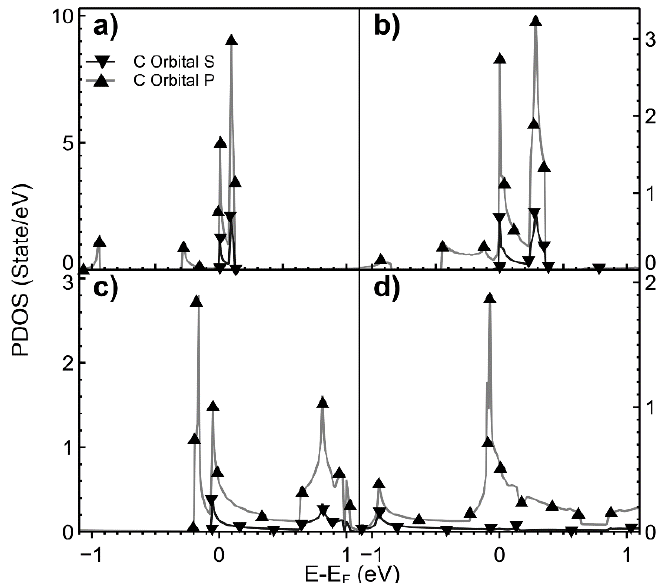
Figure 4. We show the PDOS for different values of vacancy densities. ( a ) 2.00%; ( b ) 3.12%; ( c ) 5.55%; ( d ) 12.5%. Orbitals s (  ) and p ( ▲ ) for graphene with a vacancy. ( d ) 12.5%. Orbitals s ( (cid:72) ) and p ( (cid:78) ) for graphene with a